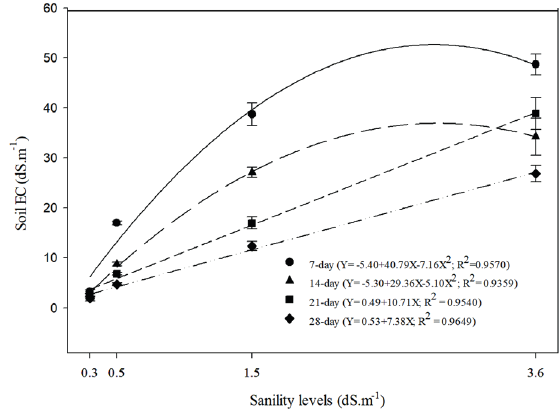
Figure 1 - Electrical conductivity (EC) of the soil grown by cactus pear cv. Miúda according to the irrigation frequencies (7-day: line solid; 14-day: line long dash; 21-day: line short dash and 28-day: line dash-dot-dot) and salinity levels. Error bars represent the standard error of the mean.